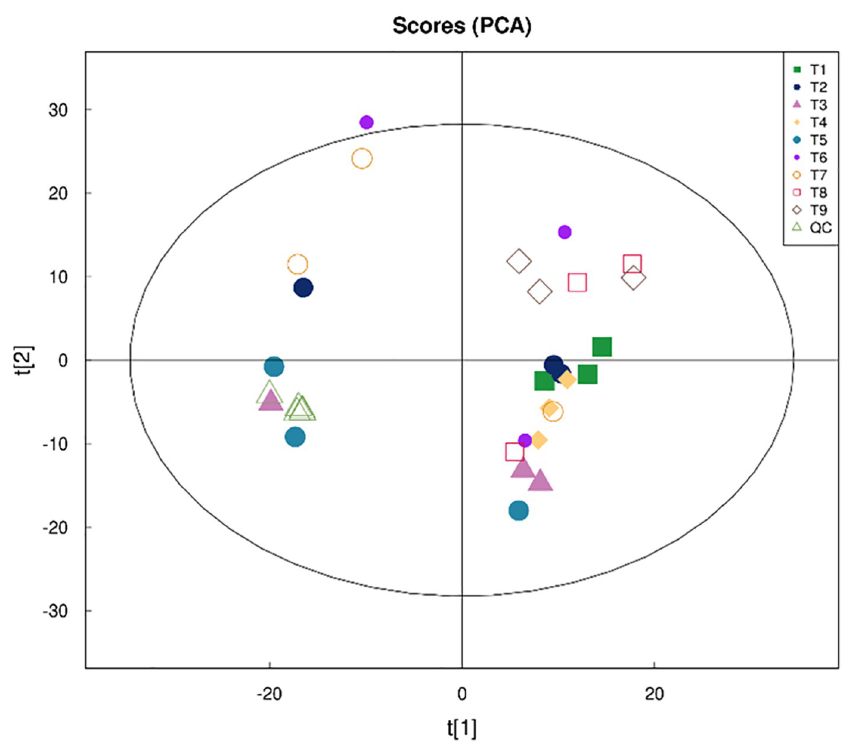
Fig 3. Principle coordinate analysis (PCA). A factorial experimental design included carbon source (starch) frequent addition on daily basis (once, twice, triple) and C/N ratio (10, 15, 20). T1; once C/N 10, T2; once C/N 15, T3; once C/N 20, T4; twice C/N 10, T5; twice C/N 15, T6; twice C/N 20, T7; triple C/N 10, T8; triple C/N 15, T9; triple C/N 20.